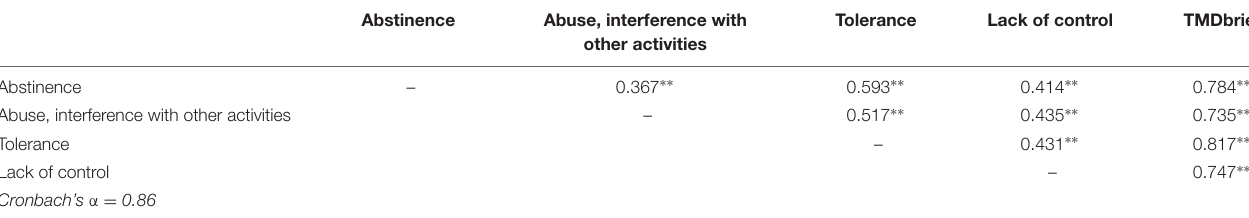
TABLE 4 | Factor correlation matrix (Mexico/Guatemala).